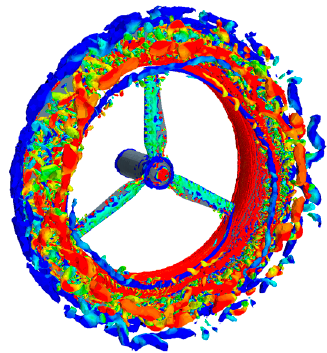
Figure 3. Vorticity calculated downstream of a WLT brim [27]. Reproduced from [27], MDPI: 2012.